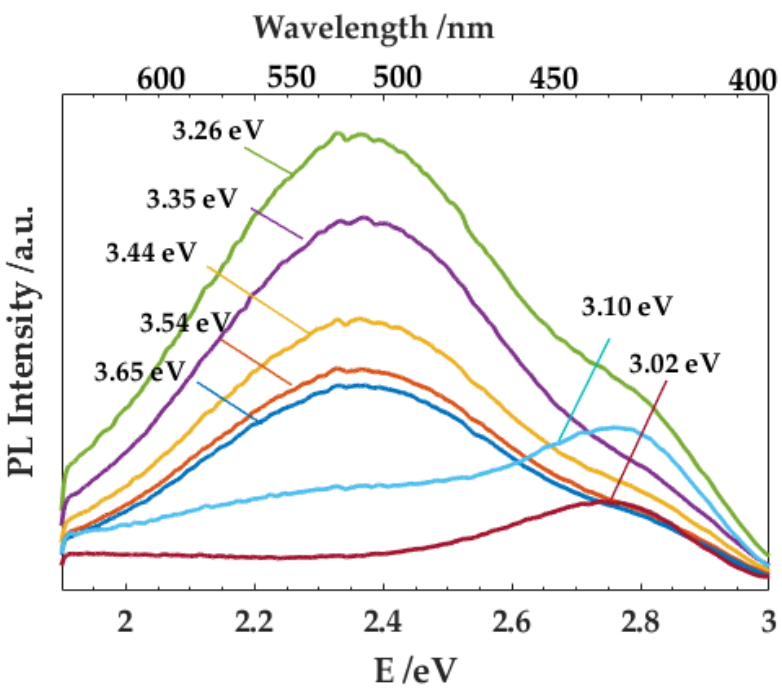
Figure 4. Time-gated spectra (delay after laser excitation = 0.5 µ s; gate width = 10 µ s) of the